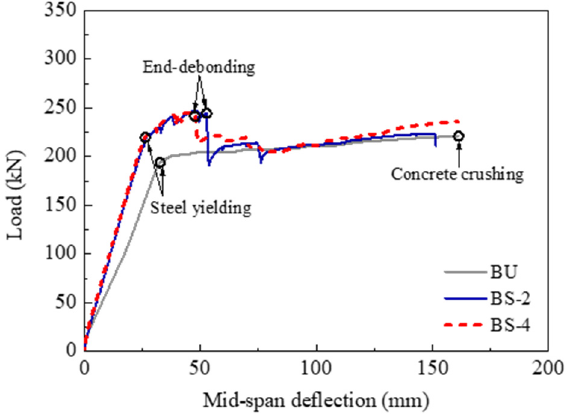
Figure 9. Influence of the CFRP